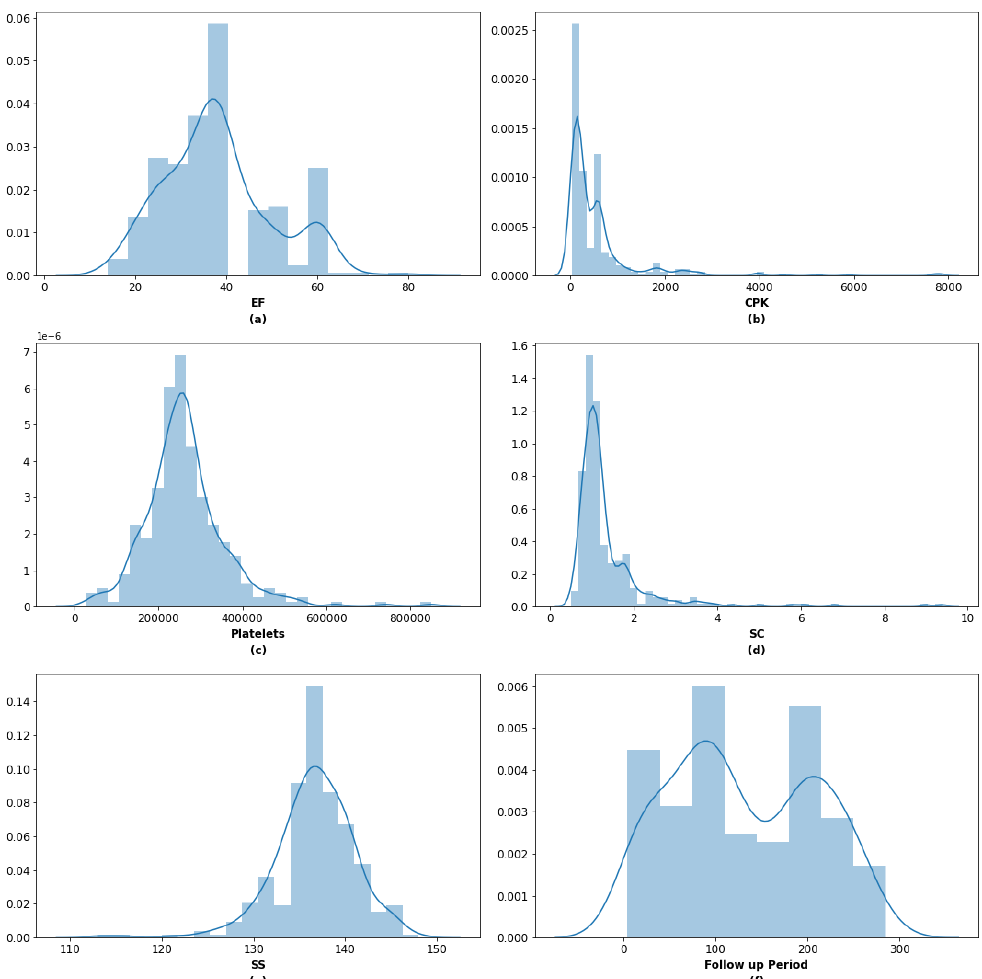
Figure 3. Dataset Distribution ( a ) EF, ( b ) CPK, ( c ) C-platelets, ( d ) SC, ( e ) SS, ( f )